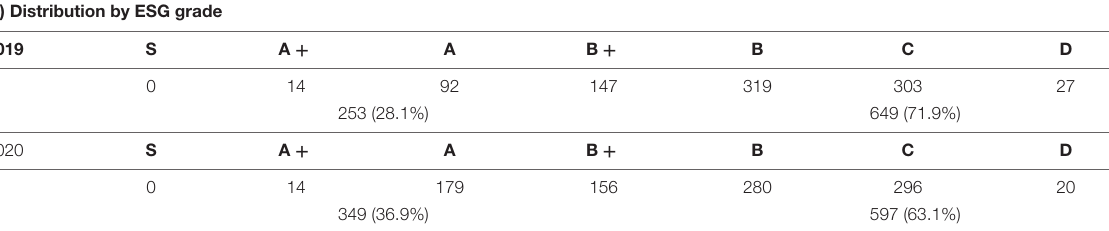
TABLE 3 | Environment, social, and governance (ESG) performance.